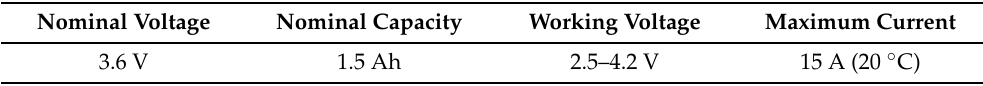
Figure 1. Battery test bench: ( a ) monitor computer, ( b ) battery test apparatus, and ( c ) temperature chamber. Table 1. Basic specifications of the Samsung 18650 battery.